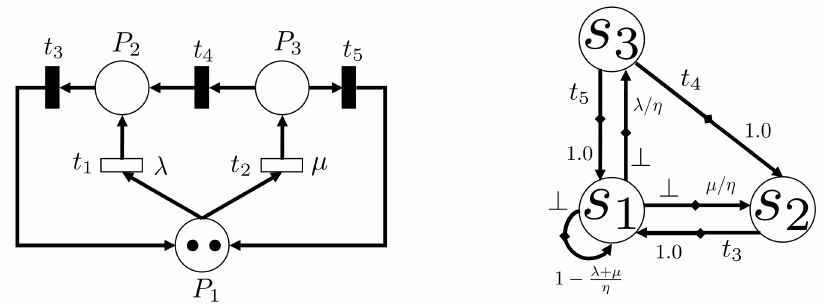
Figure 6. ( Left ) GSPNR example; ( Right ) Equivalent MDP obtained from the GSPNR on the